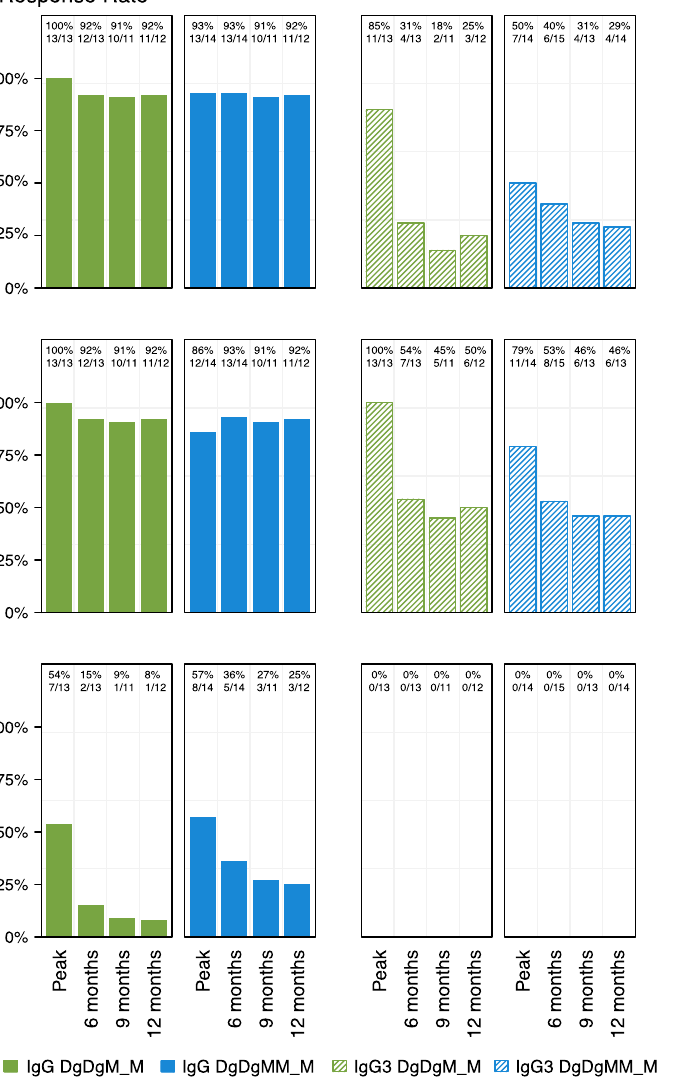
Fig 4. IgG and IgG3 response rates and magnitudes over time. (A) Total IgG and IgG3 bindingantibody responserates. (B) Total IgG and IgG3 binding antibody responsemedian magnitudes and inter-quartile range (IQR) responses. Responsesamongvaccine recipients over time at two weeks, 6 months, 9 months, and 12 months after the last vaccination in the DgDgM_Mand DgDgMM_M groups. DgDgM_Mrefers to immune responses after the last MVA in the DgDgM_Mgroup; DgDgMM and DgDgMM_Mrefer to immune responsesafter the 2nd and 3rd MVA in DgDgMM_M group, respectively. For the comparison of two visits within an arm, McNemar’s and Wilcoxon signed rank tests were used to comparethe responserates (A) and magnitudes (B) among responders, respectively.